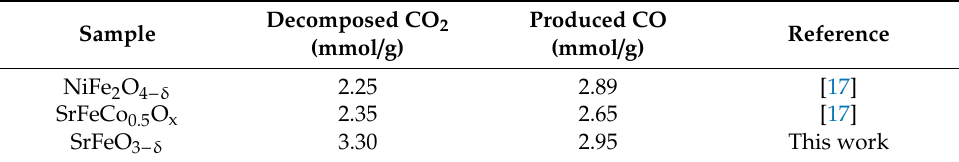
Table 1. The rate of decomposed CO 2 and generated CO in nonisothermal experiments.